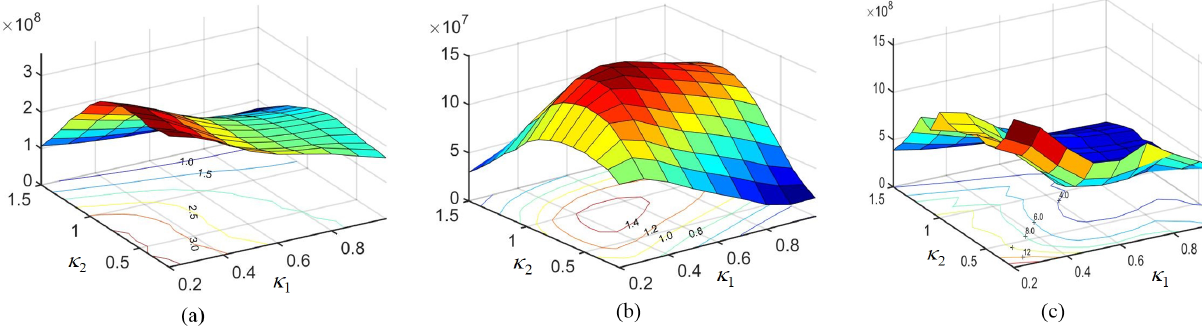
ciency and reaction force of the manipulator, is proposed as seen in Eq.